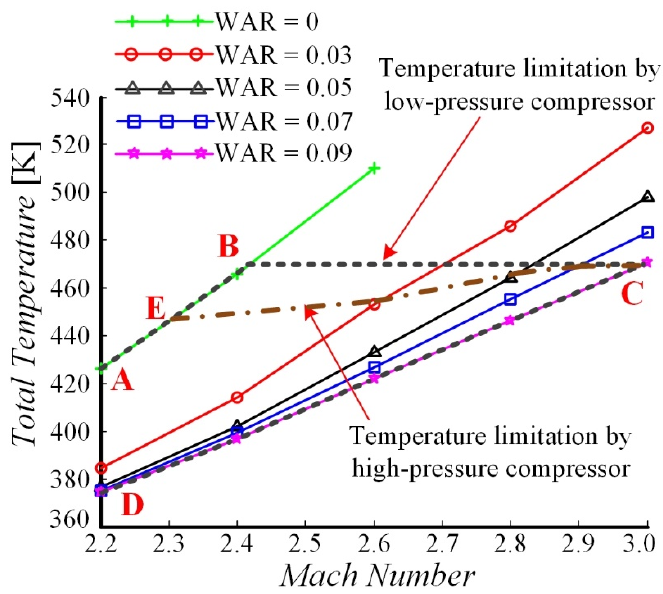
Figure 17. The range of the total temperature before the